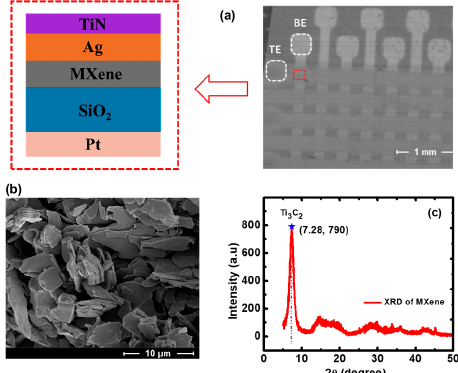
Figure 1. ( a ) Scanning electron microscope (SEM) image of the TiN / Ag / MXene / SiO 2 / Pt crossbar structure. ( b ) The surface morphology of Ti 3 C 2 powder was characterized by SEM, showing the classical multi-layered nanostructure. ( c ) The X-ray di ff raction (XRD) shows that the MXene used in this experiment is mainly composed by Ti 3 C 2